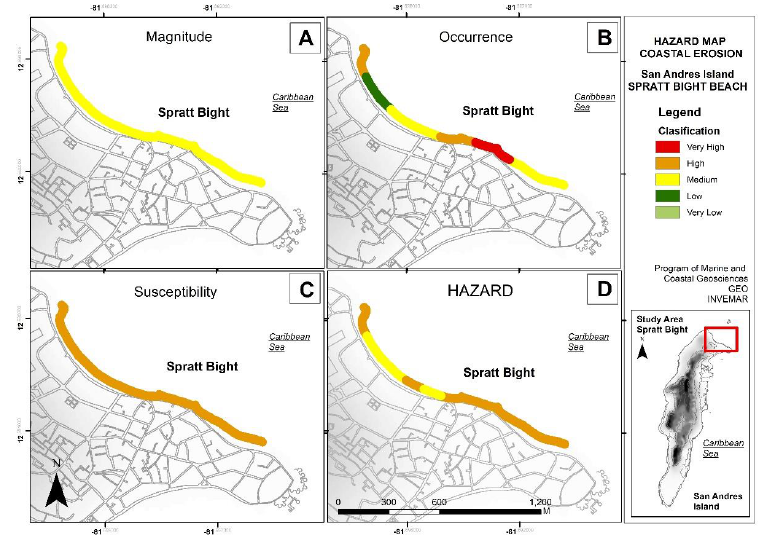
Figure 3. Hazard of coastal erosion in Spratt Bight, San Andrés Island, Caribbean coast. ( A ) Magnitude, ( B ) Occurrence, ( C ) Susceptibility, and ( D ) Hazard.